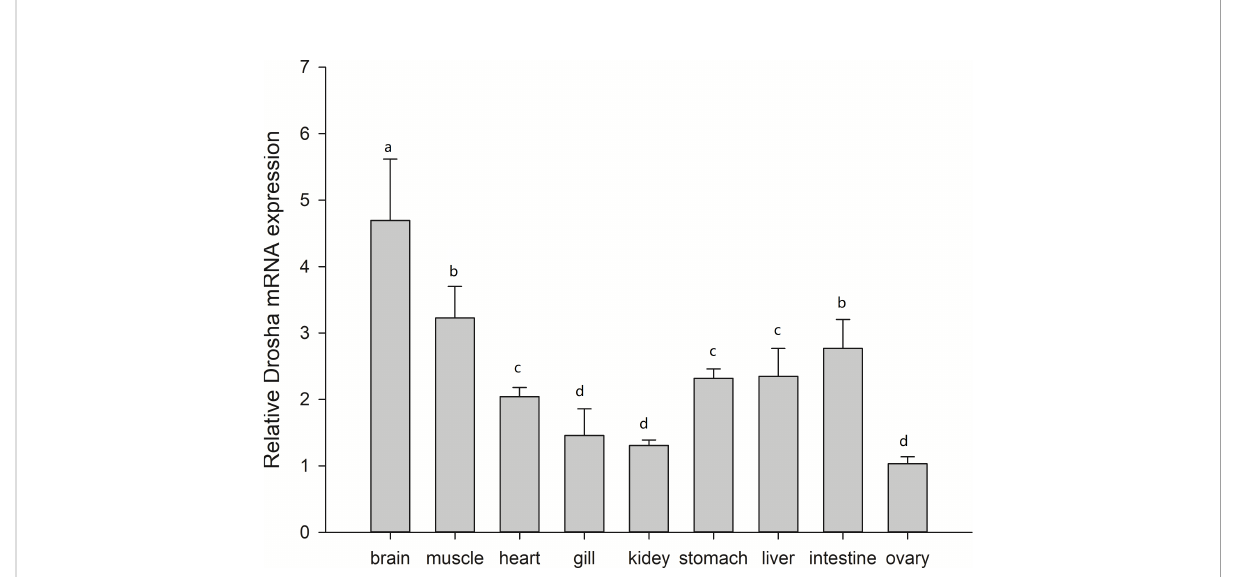
FIGURE 3 Relative expression levels of Drosha mRNA in adult tissues of Japanese fl ounder. The data are expressed as the mean ± Standard Error (SE) (n = 3) from the calibrator group (Muscle) and expression were normalized to those of b -actin. Different letters indicate signi fi cant differences between the two tissues ( P <